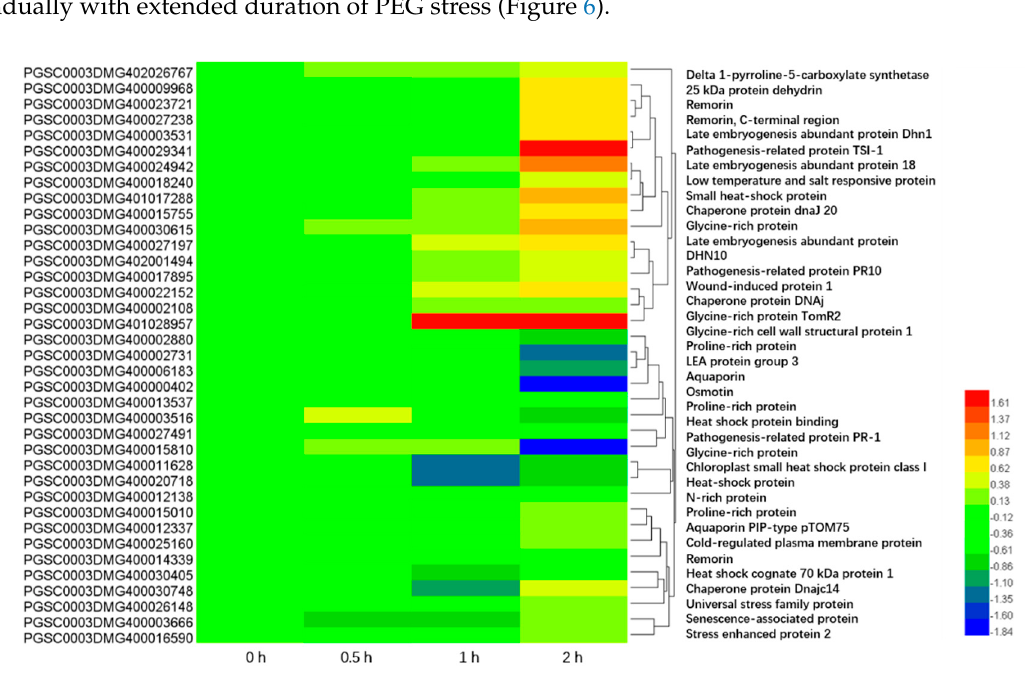
Figure 6. Genes coding for osmotic adjustment proteins differentially expressed under drought stress.